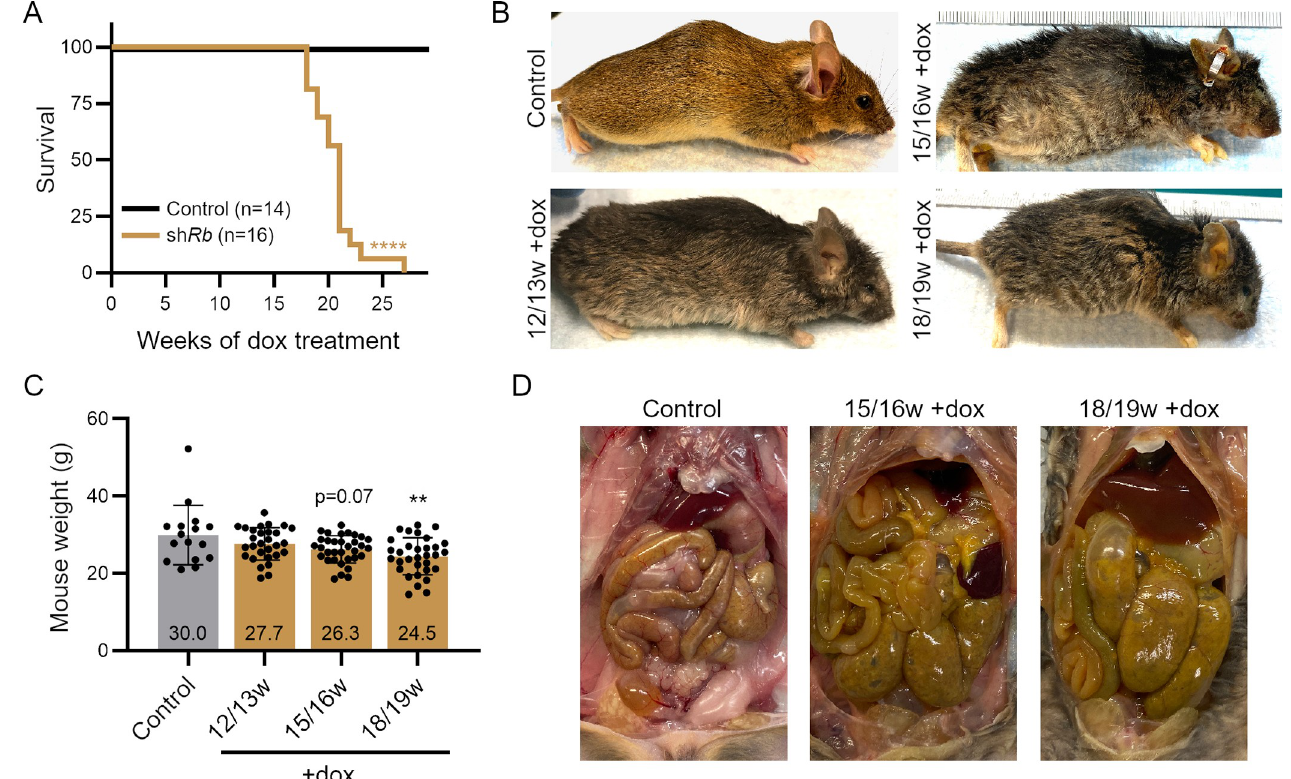
Fig 2. Phenotypic changes of long-term RB knockdown in sh Rb mice. A. Survival rate of sh Rb mice under doxycycline (dox) treatment (n = 14 Control mice, n = 16 sh Rb mice) (log-rank (Mantel-Cox) test: ���� , p < 0.0001). B. Representative images of sh Rb and control mice after 12–19 weeks (w) of dox treatment. C. Weights of sh Rb mice after different time points of dox treatment, compared to control mice (age range: 25–35 weeks) (one-way ANOVA analysis: �� , p < 0.01). D. Representative images of internal abdominal cavity in sh Rb mice with long term dox treatment. Note organ enlargements (bowels, stomach, and spleen) compared to control